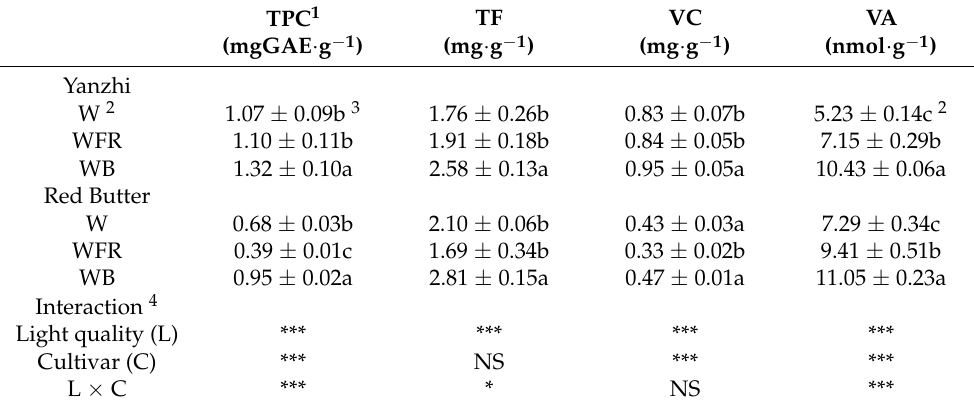
Table 6. Effects of different light quality on antioxidant compounds of